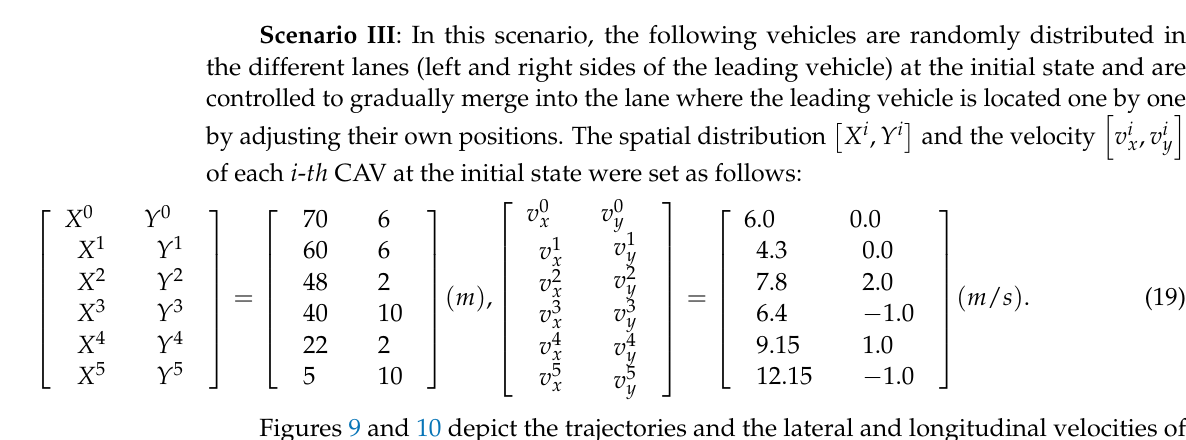
Figure 8. The velocities of the CAVs during the platoon formation process: ( a ) lateral velocity; ( b ) longitudinal velocity (scenario II).